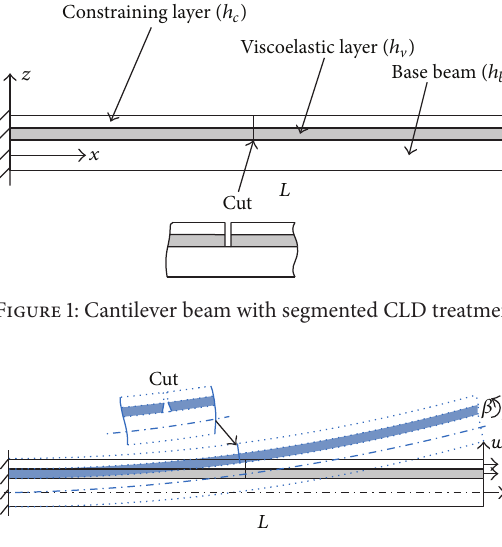
Figure 2: Deformation of the beam with segmented CLD treat-